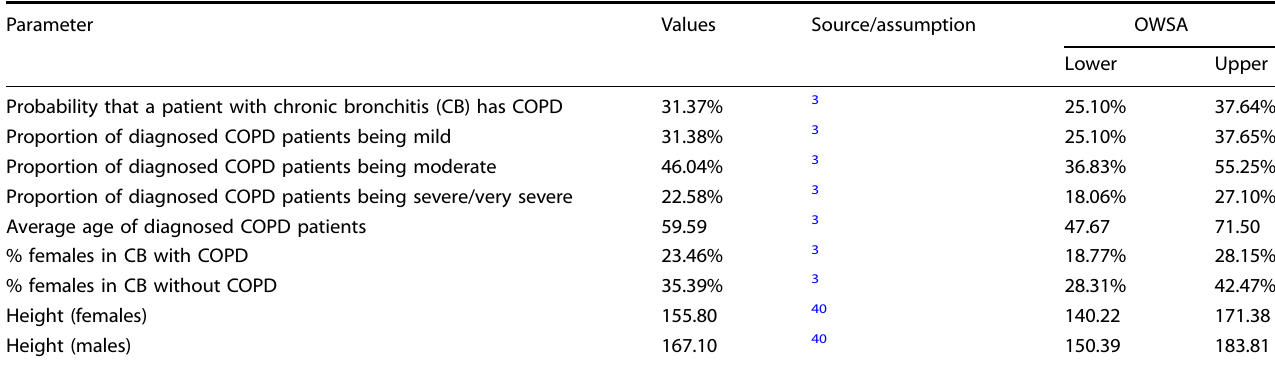
Table 3. Screening cohort